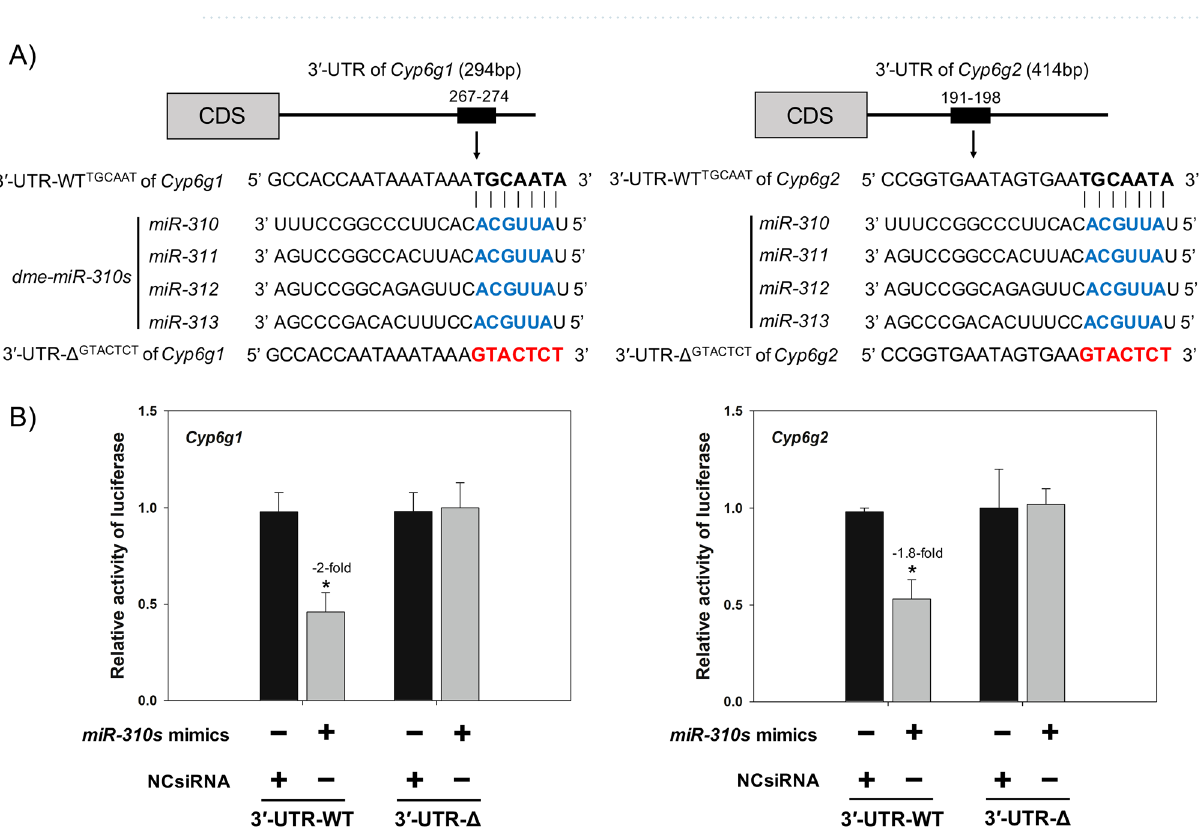
Figure 3. Validation of miR-310s -mediated regulation of Cyp6g1 and Cyp6g2 transcripts in vitro. ( A ) Predicted target binding site (3 ′ -UTR-WT TGC AAT ) and mutated target binding site (3 ′ -UTR-Δ GTA CTC T ) of miR-310s within the 3 ′ -UTR of the putative target Cyp6g1 and Cyp6g2 from 91-R strain. ( B ) Relative luciferase activity in S2 cells co-transfected with miR-310s or negative control mimics and the wide- or mutant-type luciferase reporter vectors (3 ′ -UTR-WT TGC AAT and 3 ′ -UTR-Δ GTA CTC T ). An asterisk (*) indicate a difference across the treatment groups at p <